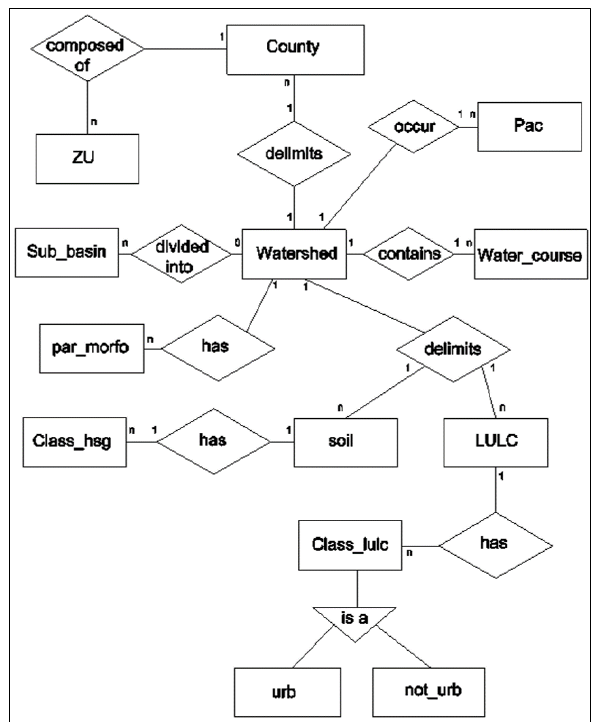
Figure 2: Diagram of